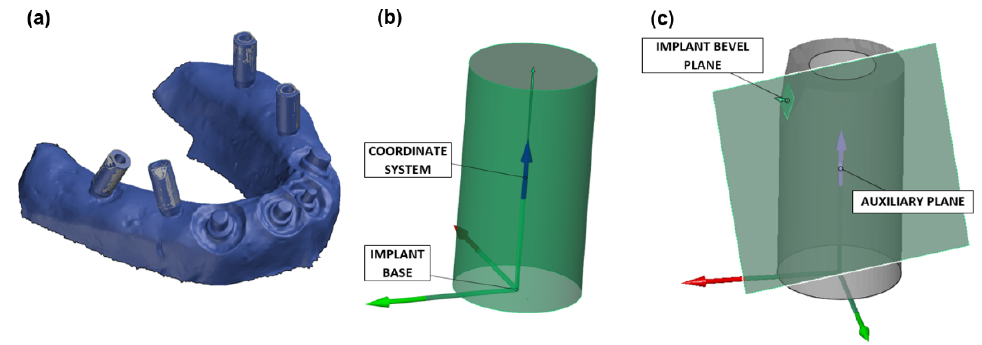
Figure 10. Showing ( a ) implant positioning on the master model using best ‐ fit method, ( b ) orienta ‐ tion of the local coordinate system of the master 3D model, and ( c ) determination of the Y axis direc ‐ tion in the local coordinate system.